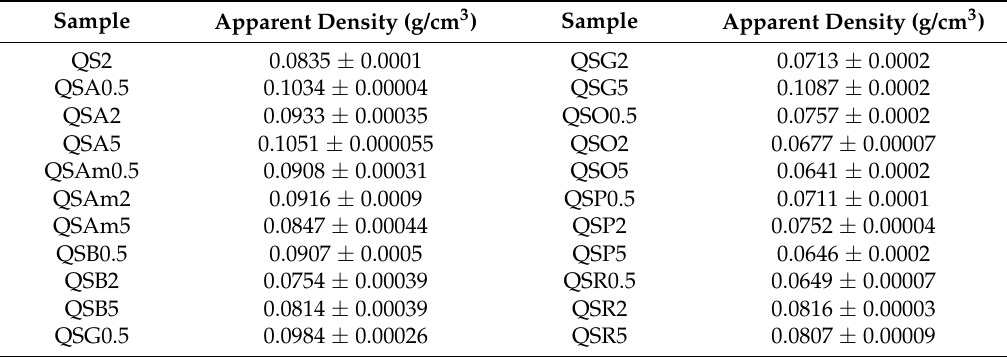
Table 2. Apparent density values of the films.